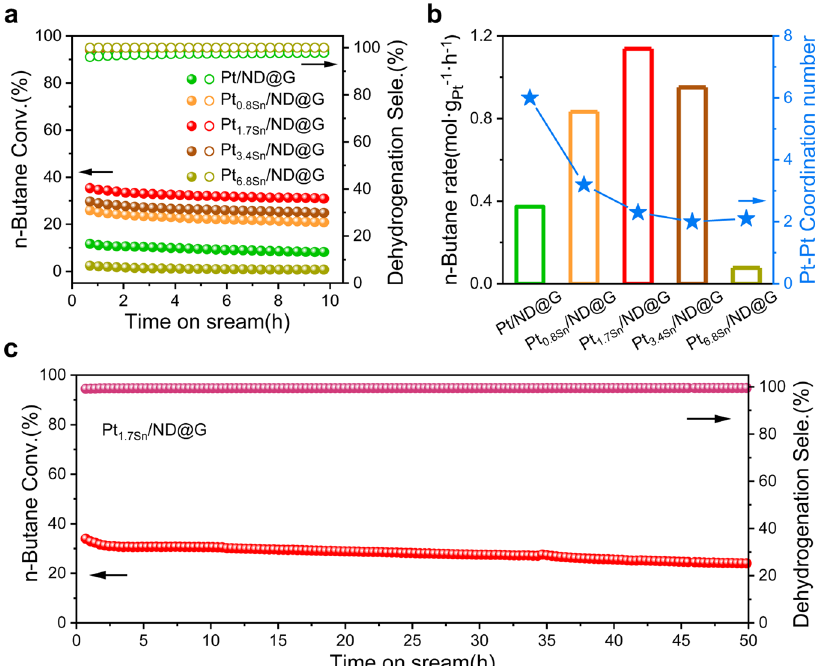
Fig. 3 Catalytic performance for n-butane DDH. a n-butane conversion and C 4 ole fi n selectivity of Pt/ND@G, Pt 0.8Sn /ND@G, Pt 1.7Sn /ND@G, Pt 3.4Sn / ND@G and Pt 6.8Sn /ND@G. b the conversion rate of n-butane and Pt – Pt CN. c stability test over Pt 1.7Sn /ND@G at 450 °C.